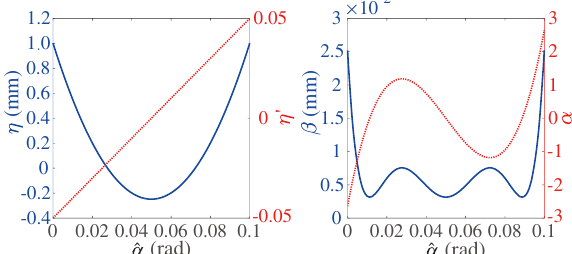
FIG. 3. The matched dispersion (left) and longitudinal Twiss function inside dipole C (right). This distribution minimizes the partial eta effect.